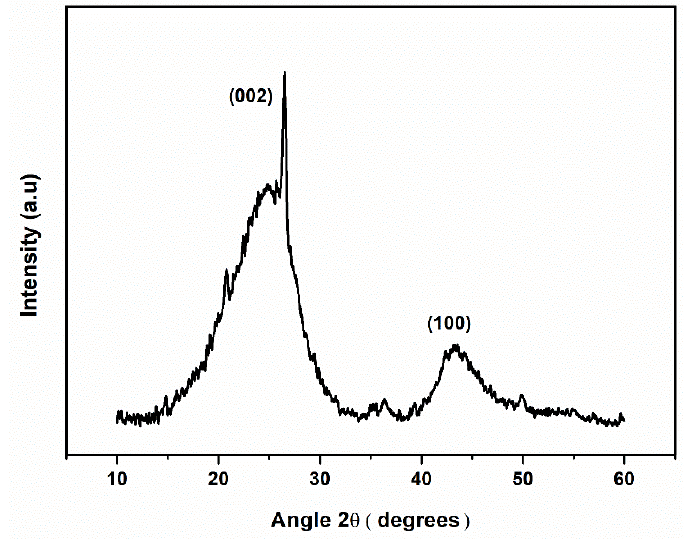
Figure 3. XRD pattern of coconut shell biochar.